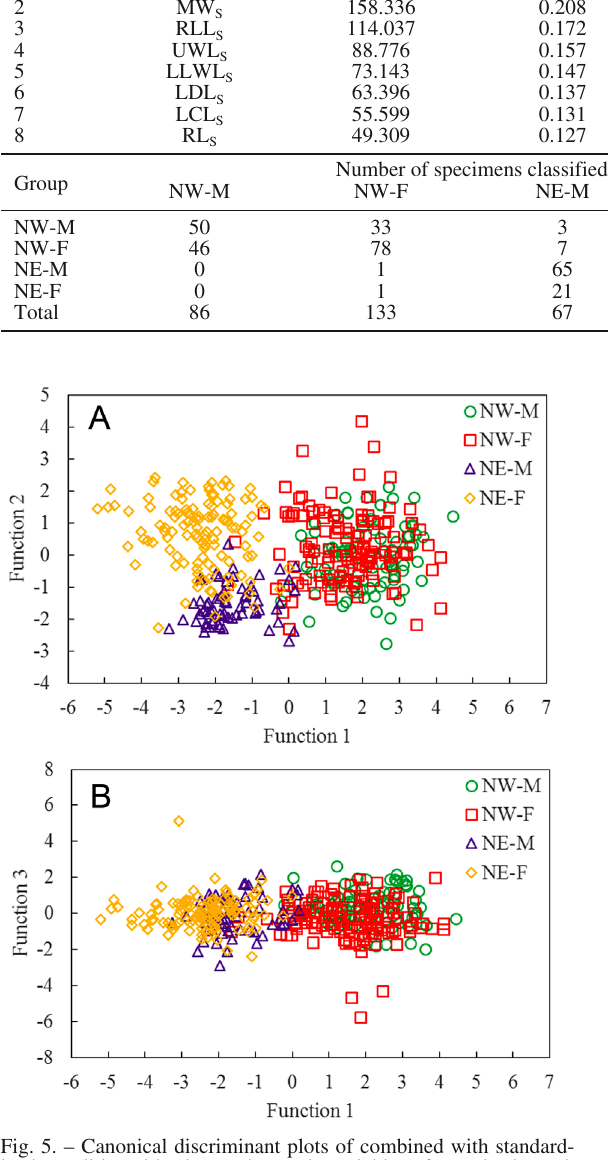
Table 8. – The results estimated from stepwise discriminant analysis of combined standardized statolith and beak variables for each sex of two populations, and a classification matrix with percentages of correctly classified individuals and cross-validation results. Step